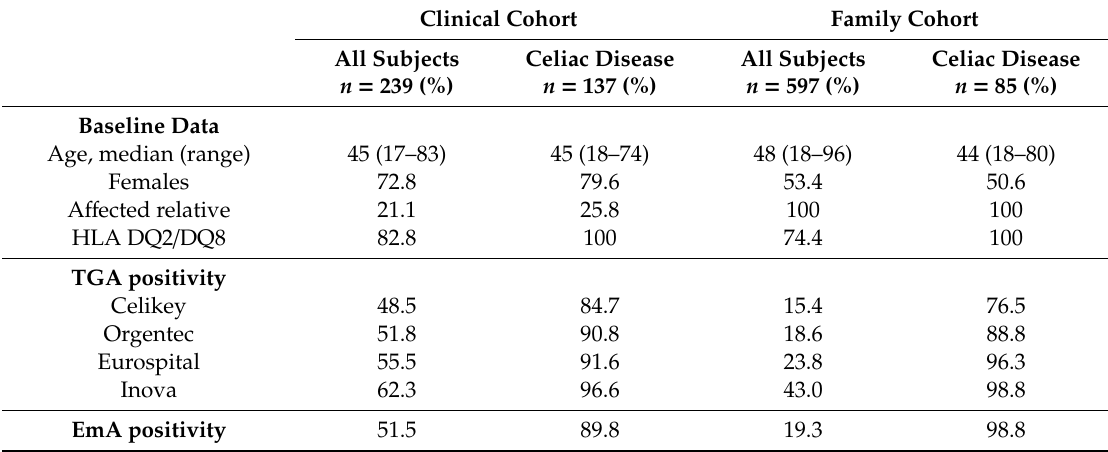
Table 1. Baseline characteristics and positivity for the serological assays tested in the two study cohorts. Clinical Cohort Family Cohort